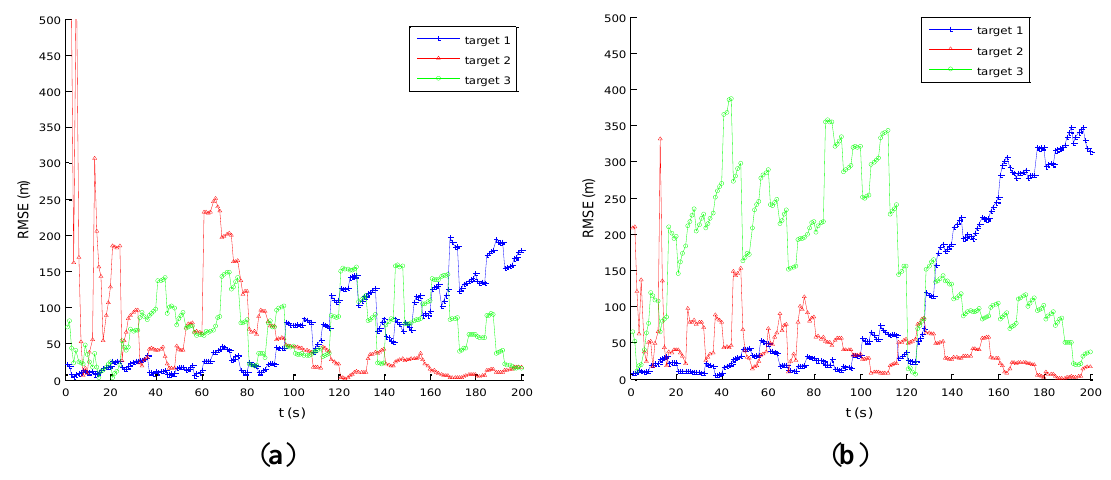
Figure 8. RMSE of position for high measurement noise,